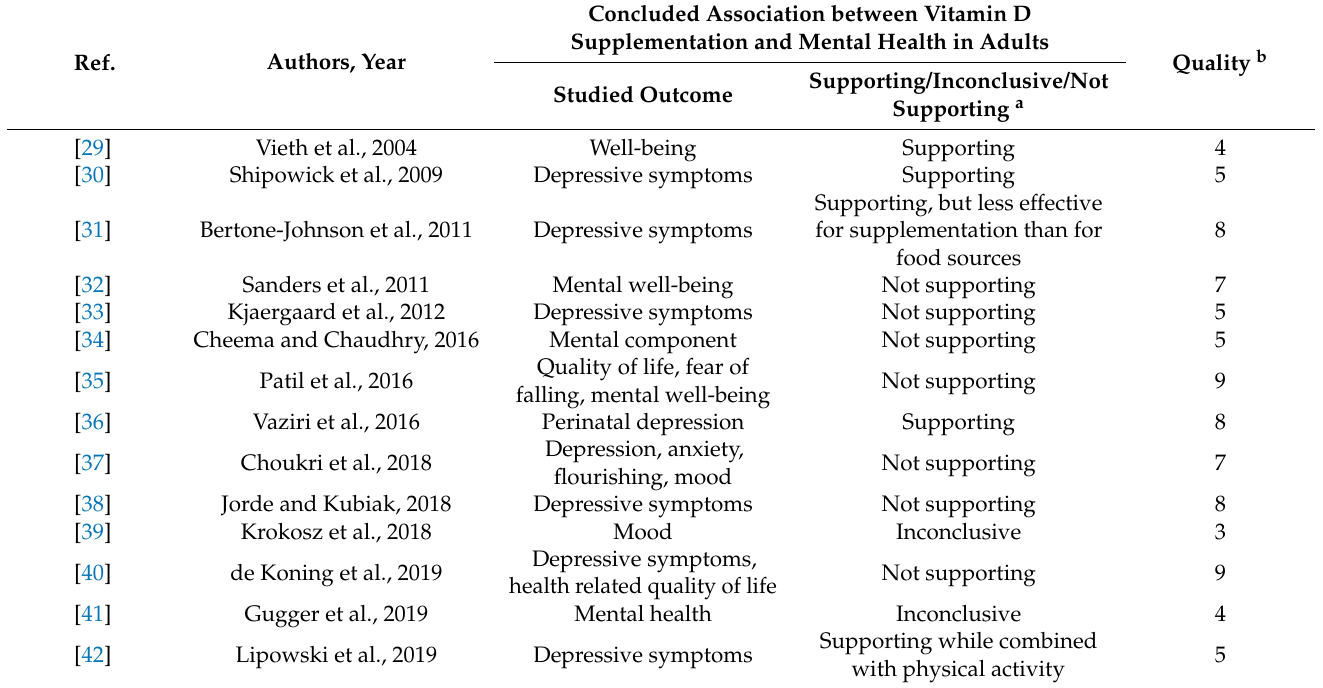
Table 5. The summary of concluded association between vitamin D supplementation and mental health in adults, accompa- nied by the Newcastle–Ottawa Scale (NOS) total score for the studies included in the systematic review.